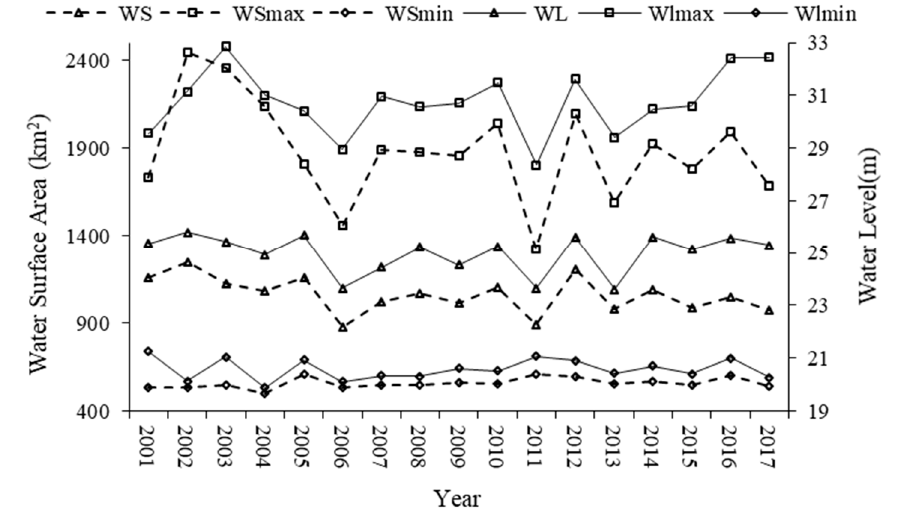
Figure 19. Water surface area and water level trends from 2001–2017.